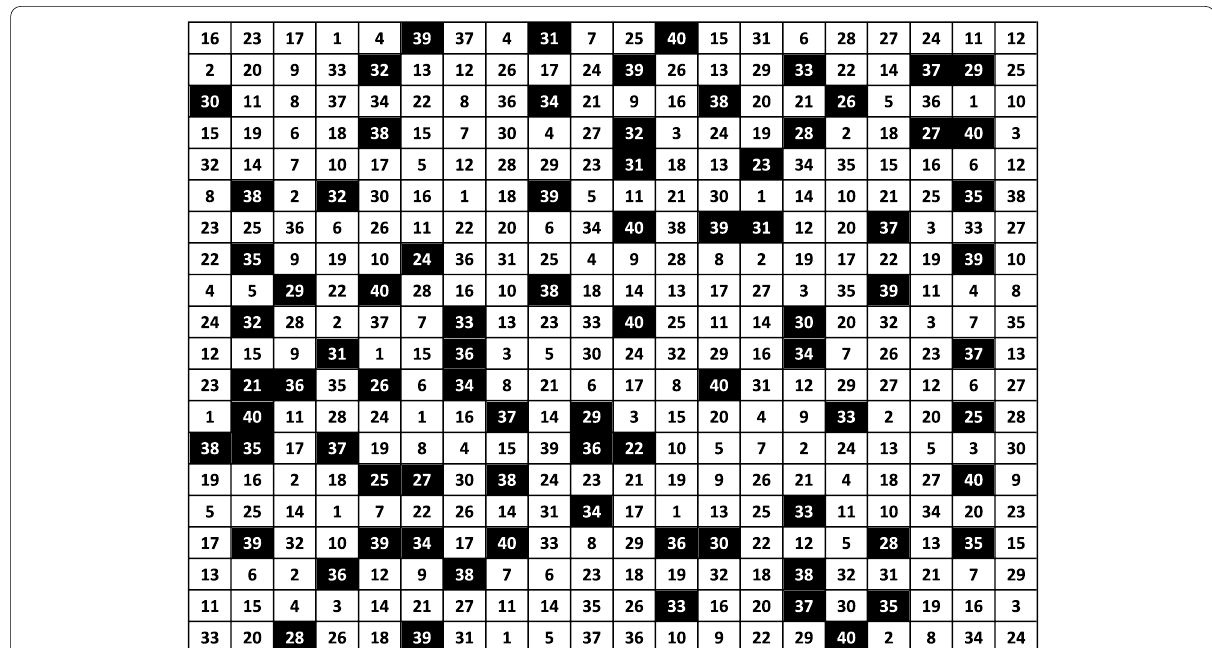
Fig. 4 The ONA seed orchard layout with 20% genetic thinning (black cells) following the linear deployment (ONA, GTL deployment)